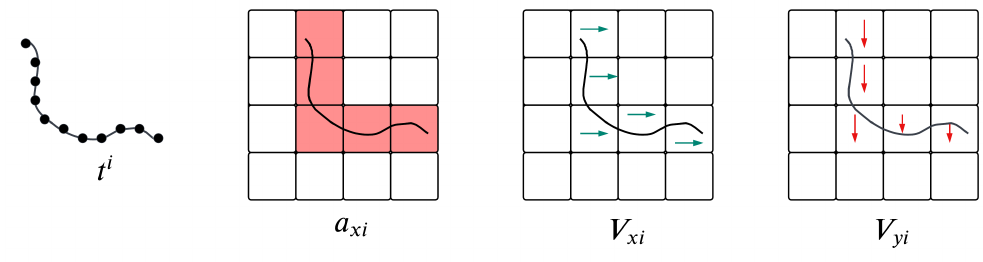
Figure 1. Vectorized trajectory representation of a mobile agent [9]. t i is a sample trajectory which is represented in a discretized world with an R × C grid size, and width w . The trajectory is represented ] (cid:62) , where normalized velocities are represented by v as a vector y i = [ v (cid:62) , v (cid:62) , a (cid:62) xi yi i the binary activeness